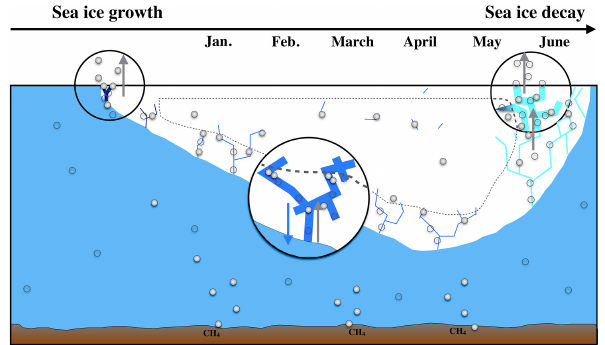
Figure 4. Schematic figure of CH 4 incorporation and release in sea ice. Sizes are intentionally disproportionate to highlight processes better. The area above the dotted line represents the impermeable layers. The small filled and empty circles represent CH 4 in gas bub- bles and in dissolved state respectively. Upward grey arrows in- dicate the upward transport of gas bubbles due to their buoyancy, while downward blue arrows indicate the removal of dissolved gas through brine drainage. Large black circles zoom in on particular processes described in the text (Sect. 4.2): gas exchanges at the be- ginning of ice growth, gas accumulation predominantly under the impermeable layers and gas bubble escape during ice decay. Dark blue, light blue and cyan strokes in ice represent brine channels with high, moderate or low salinity